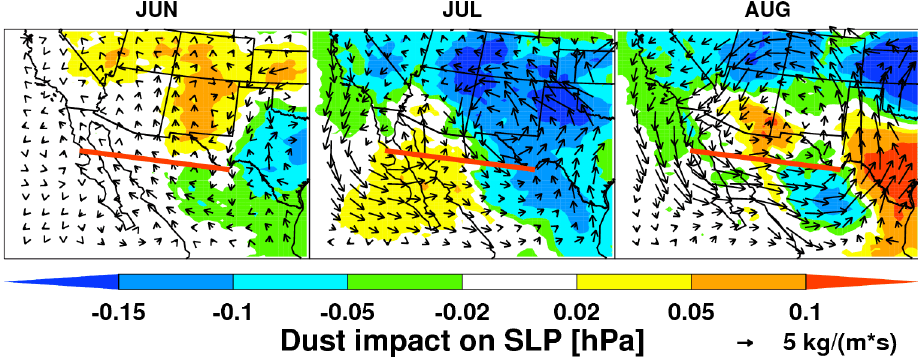
Fig. 11. Spatial distributions of monthly mean dust-induced change of sea level pressure (SLP) and integrated moisture fluxes from the Figure 11 Spatial distributions of monthly mean dust-induced change of sea level 7 WRF-Chem simulations in June, July, and August averaged for 1995–2009 over the NAM region. The red line represents the cross section at 29 ◦ N from 115 ◦ W to 105 ◦ W. pressure (SLP) and integrated moisture fluxes from the WRF-Chem simulations in June, 8 July, and August averaged for 1995-2009 over the NAM region. The red line represents 9 the cross section at 29 o N from 115 o W to 105 o W. 10